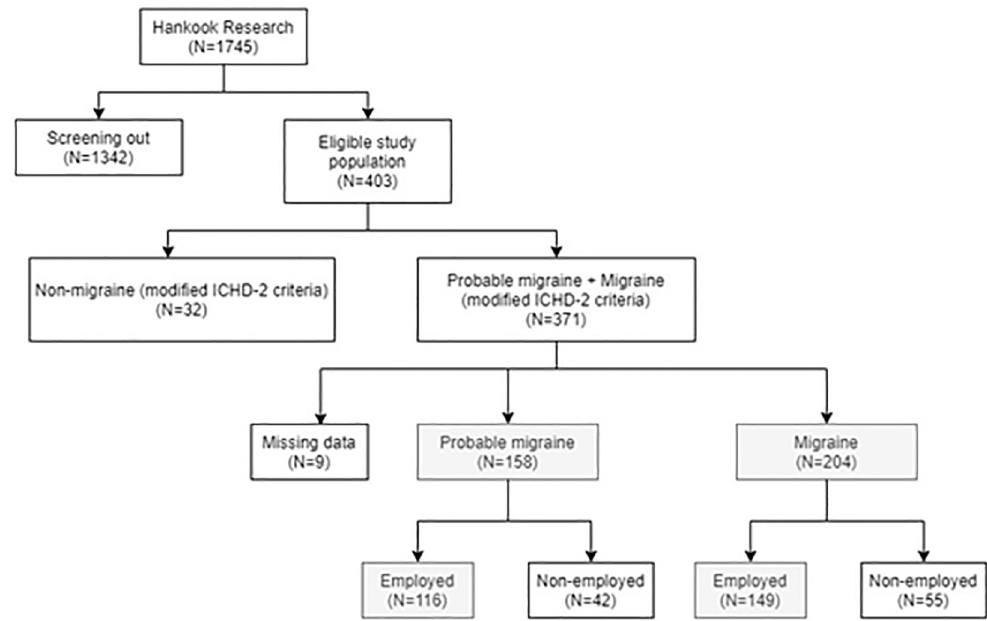
Fig 1. Flow chart of study sample selection. Abbreviations: ICHD-2, International Criteria of Headache Disorders 2nd